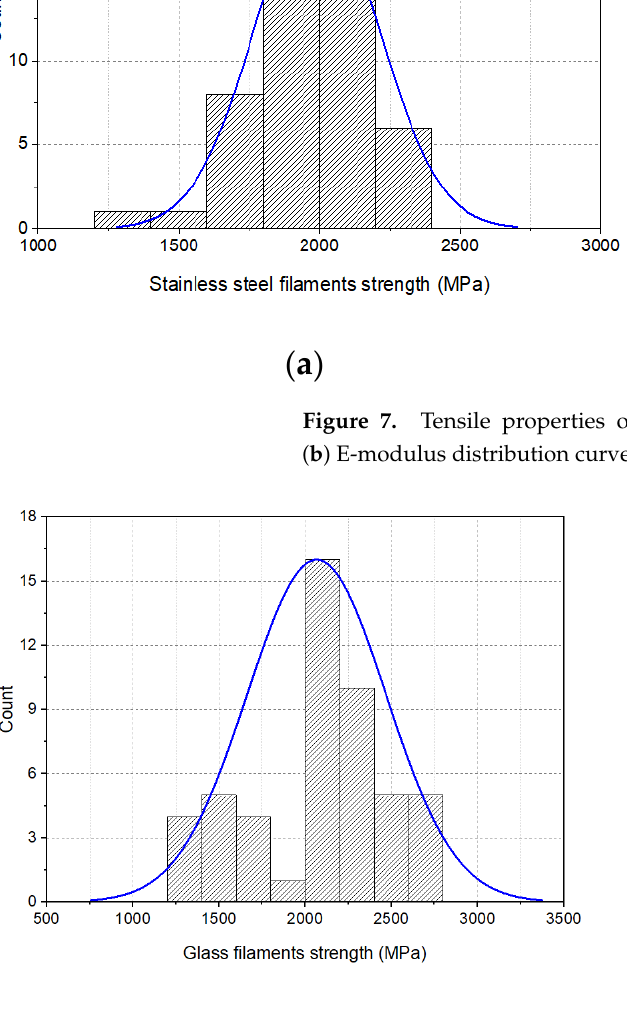
Figure 7. Tensile properties of stainless-steel filaments: ( a ) strength distribution curve and ( b ) E- modulus distribution curve.